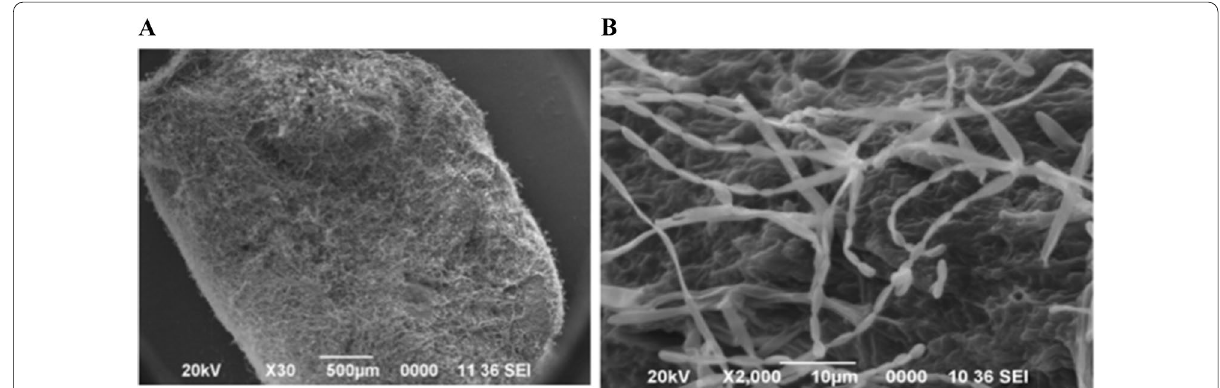
Fig. 1 Scanning electron microscope (SEM) images of Isaria fumosorosea infected cadaver of Eublemma amabilis a. a Dead larvae, b chain of